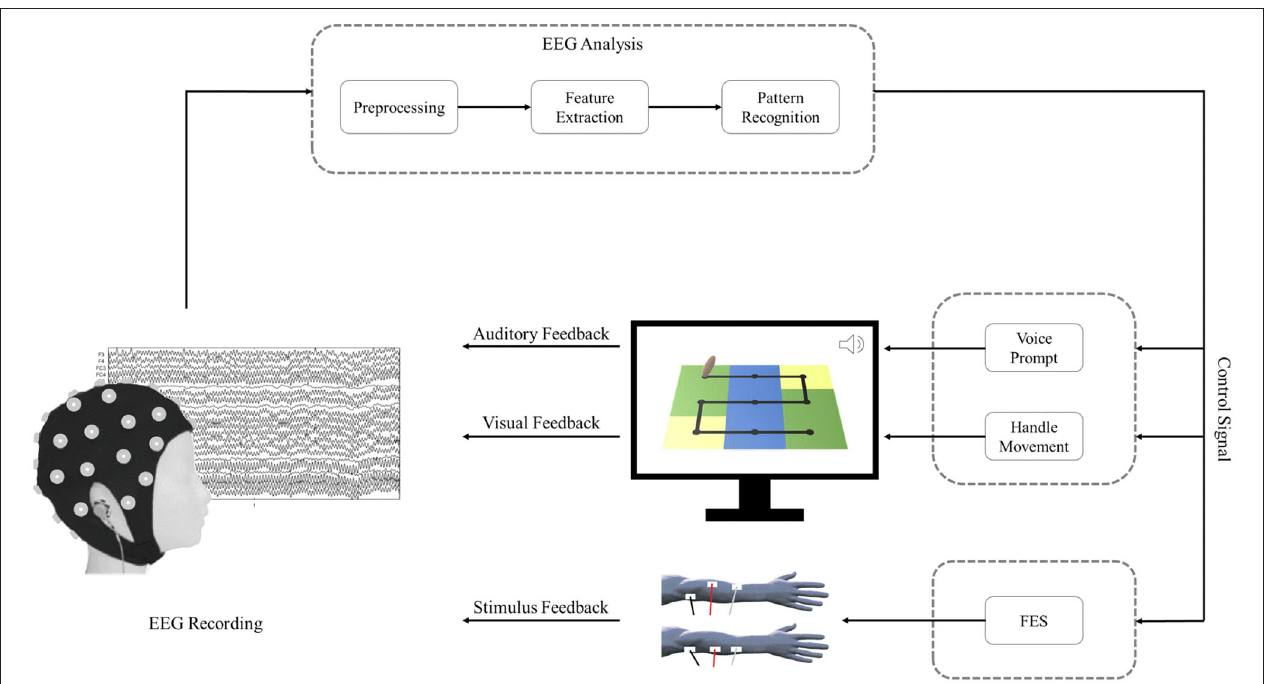
FIGURE 1 | The schematic of the BCI–FES